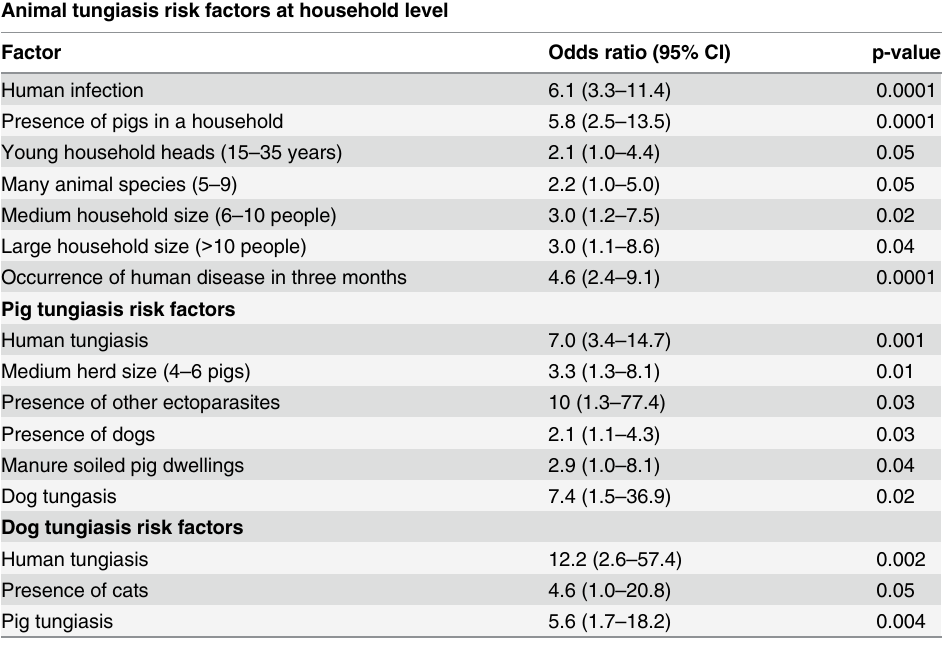
Table 4. Risk factors of tungiasis in animals at household